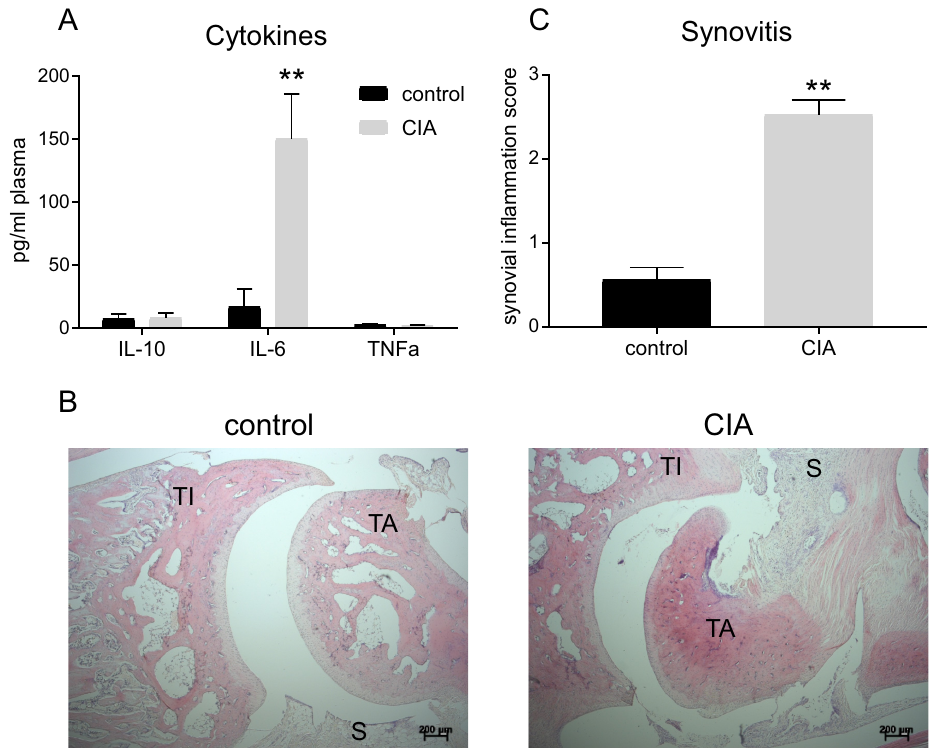
Fig 2. Indices of increased inflammation in the rat CIA model of RA. Plasma inflammatory cytokine IL-6 concentration (A) in the CIA group (n = 7) was greater than in control (n = 6) at the end of the study (day 18), but TNF α and IL-10 levels were similar to control. Histopathology (B), scale bar 200 μ m, confirmed at the end of the study the development of arthritis in the tibiotalar joints of the CIA rats (n = 7) only, with increased cellularity, synovium lining thickness, and synovitis (C). TA- talus; TI- tibia; S- synovium. Results represent mean ± SEM. �� p < 0.01, significantly different from control. peroxisome-proliferator activated receptor gamma coactivator 1 beta (Ppargc1b), solute car- rier family 2 member 4 (Slc2a4) and vascular endothelial growth factor alpha (Vegfa) were